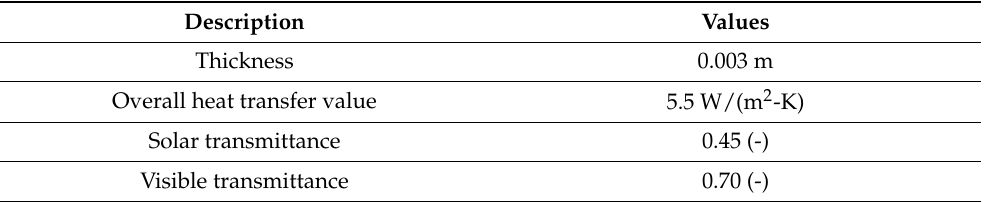
Table 4. Single-glazed aluminum-framed windows.